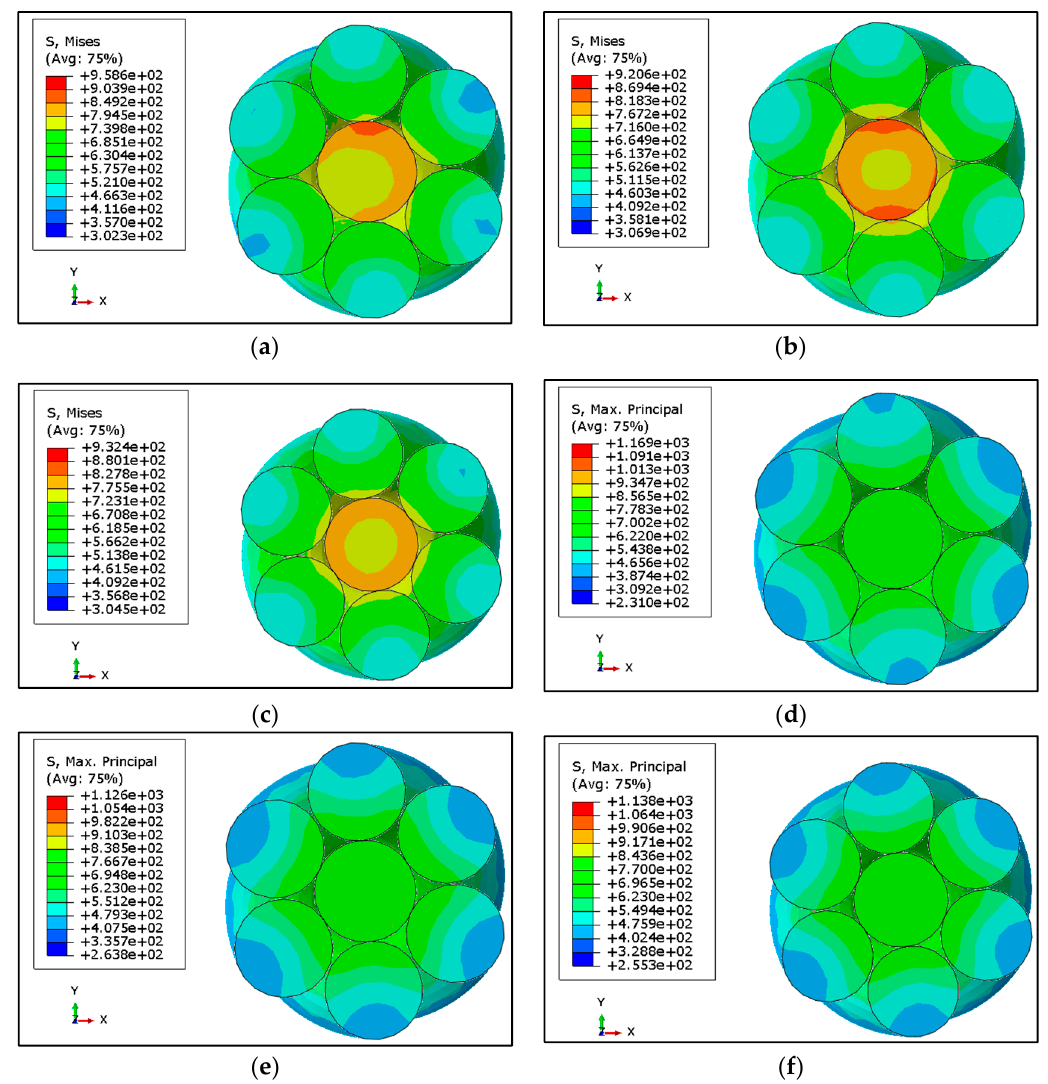
Figure 2. Von Mises and Max Principal stress distribution in wire rope strand under axial loading for different surface conditions ( a ) Von Mises stress distribution without friction. ( b ) Von Mises stress distribution with coefficient of friction = 0.1. ( c ) Von Mises stress distribution with coefficient of friction = 0.2. ( d ) Max Principal stress distribution without friction. ( e ) Max Principal stress distribution with coefficient of friction = 0.1. ( f ) Max Principal stress distribution with coefficient of friction = 0.2.